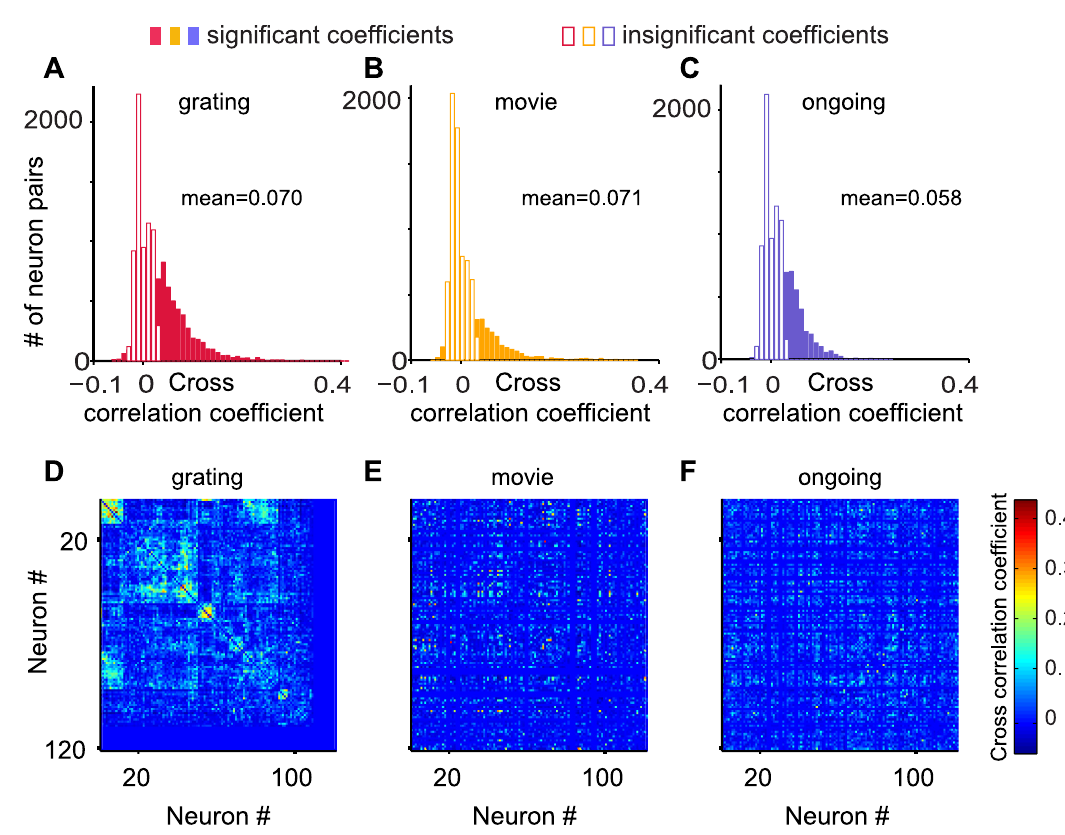
Fig 6. The cross-correlation coefficients among the pairs of neurons rearrangefor different stimulus conditions. (A-C) The distributionsof the zero-lagpairwisePearson cross-correlation coefficients of the thresholdedinferred spike probabilities for the three stimulus conditions. Significance testing was obtainedby comparing with uncorrelatedspike trains of the same mean rate and adoptinga p-value threshold of 0.1. (D) The cross-correlation coefficient matrix for the grating stimulus, with the matrix clusteredusing a hierarchicalclusteringalgorithm(see Materials and methods). A subset of rows/columns are blank becauseneuronswith noisy signal with no apparentcalcium transient for a give stimulus conditionwere detected by visual inspectionand excludedfrom further analysisfor that stimulus condition. (E, F) The cross-correlation coefficient matrix for the other two stimulus conditions(movie, ongoing),whilemaintaining the order of neuronsas in (D). This displayillustrates the reorganization of the cross-correlation when varyingthe stimulus